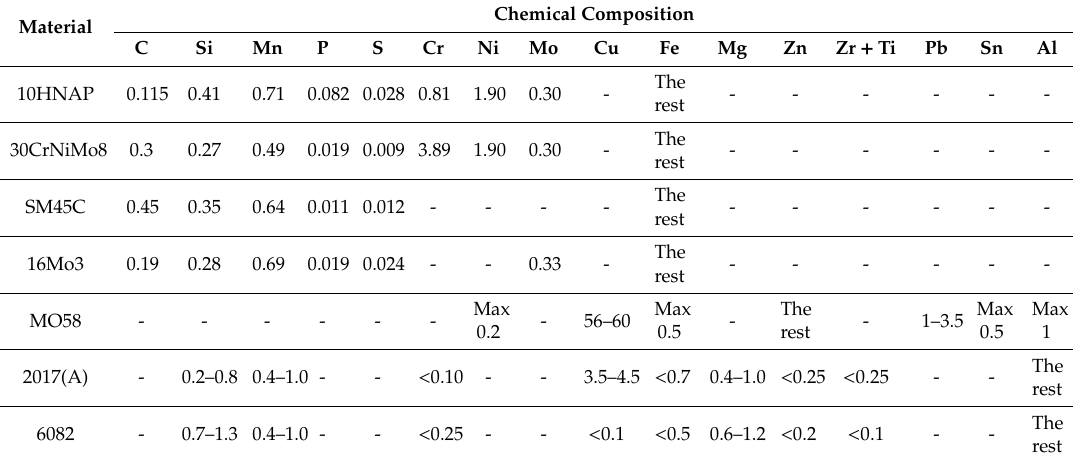
Table 1. Chemical composition of the tested materials (%).